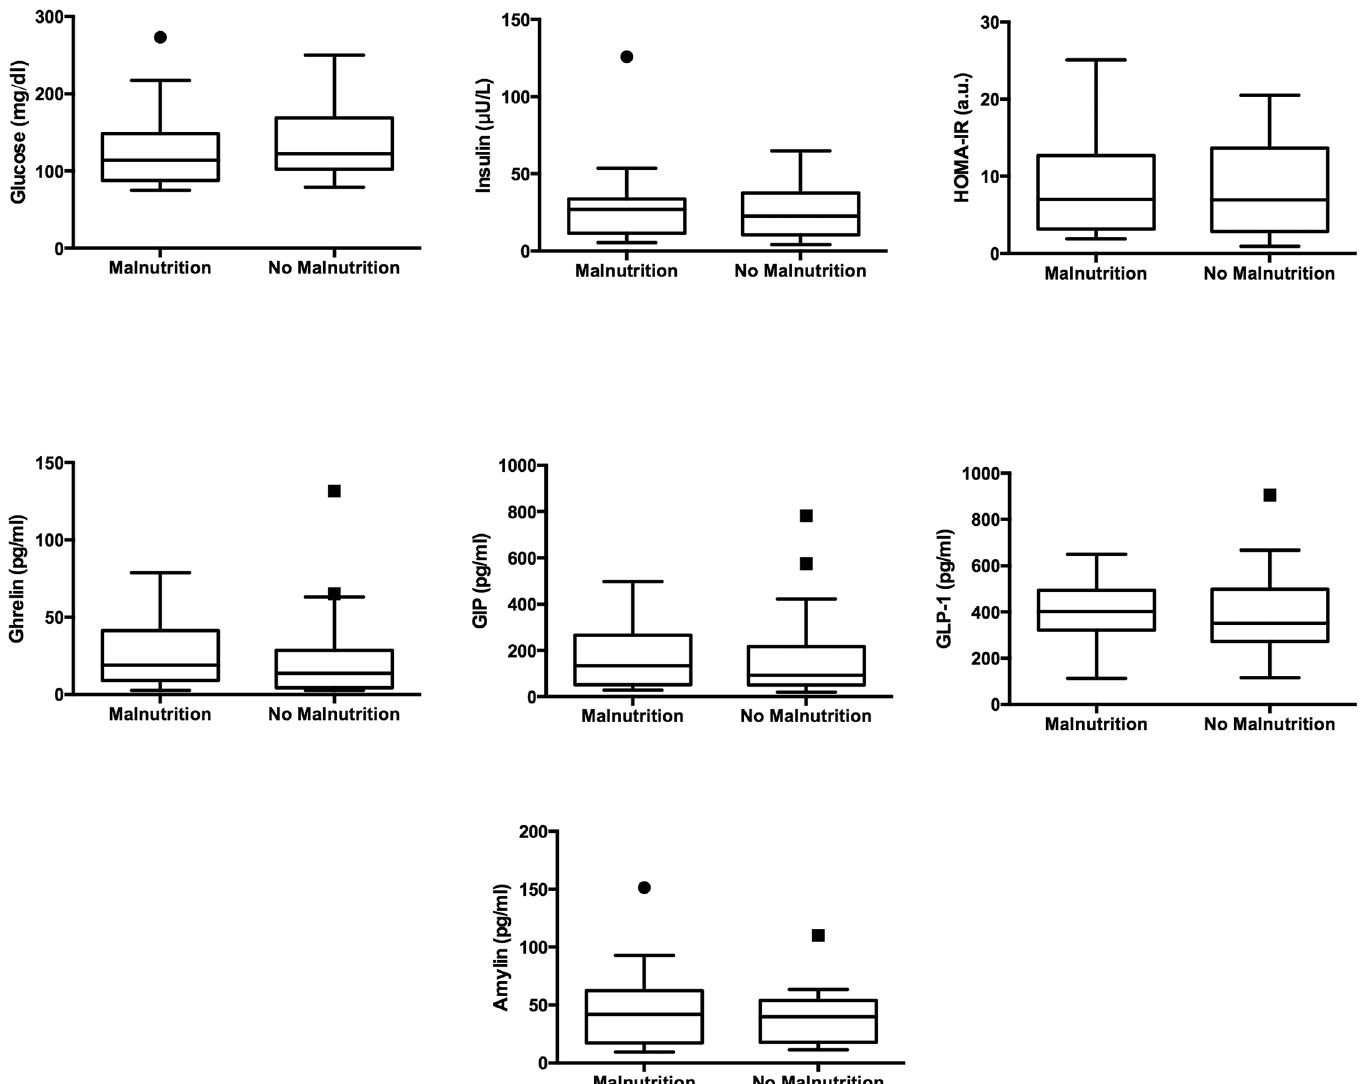
Fig 2. Tukey box whisker plots of circulating concentrations of insulin resistance markers and metabolic hormones. GIP-1, gastric inhibitory peptide; GLP-1, glucagon-like peptide 1; HOMA-IR, homeostatic model assessment insulin resistance; * , p <